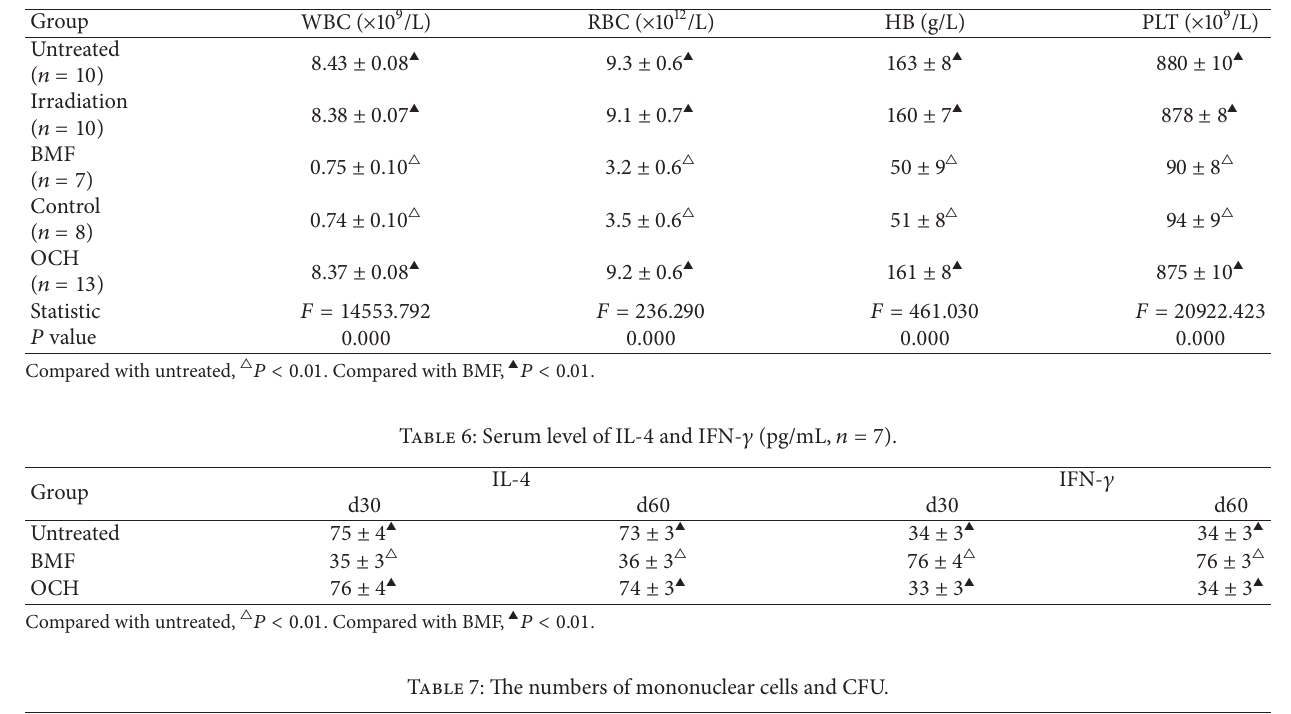
Table 5: Complete blood cell count on d60 after treatment.